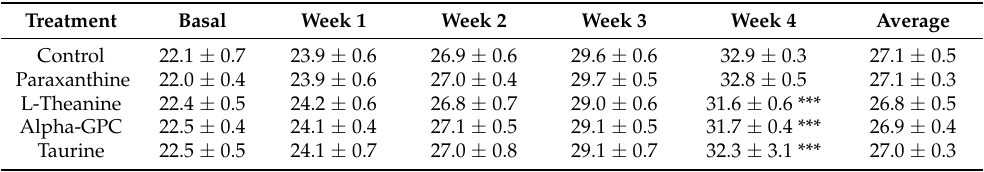
Table 2. Effect of test substance on body weight (in grams). Data are mean ± SD for n = 8 mice in each group. *** = Different than paraxanthine ( p < 0.001).